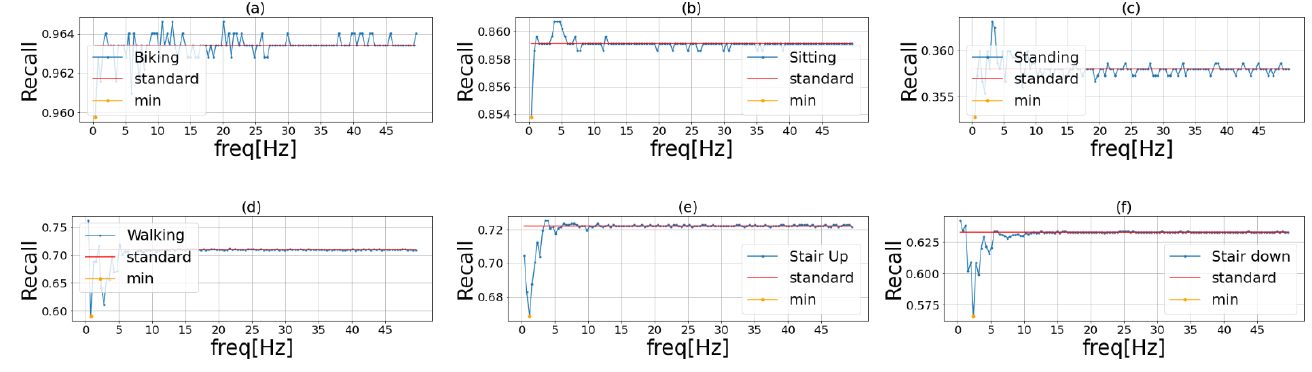
Figure 6. Important frequency of each activity in HHAR. The blue line in the graph shows the recognition accuracy when we masked the frequencies of the original sensor data in order. The red line shows the recognition accuracy when we used the original data. The yellow point is the lowest recognition accuracy when we used the frequency masked data. Each activity is ( a ) Biking, ( b ) Sitting, ( c ) Standing, ( d ) Walking, ( e ) Stair Up, and ( f ) Stair down. Table 4. Accuracy of the three models using each dataset. Bold type indicates the highest accuracy using the respective dataset.